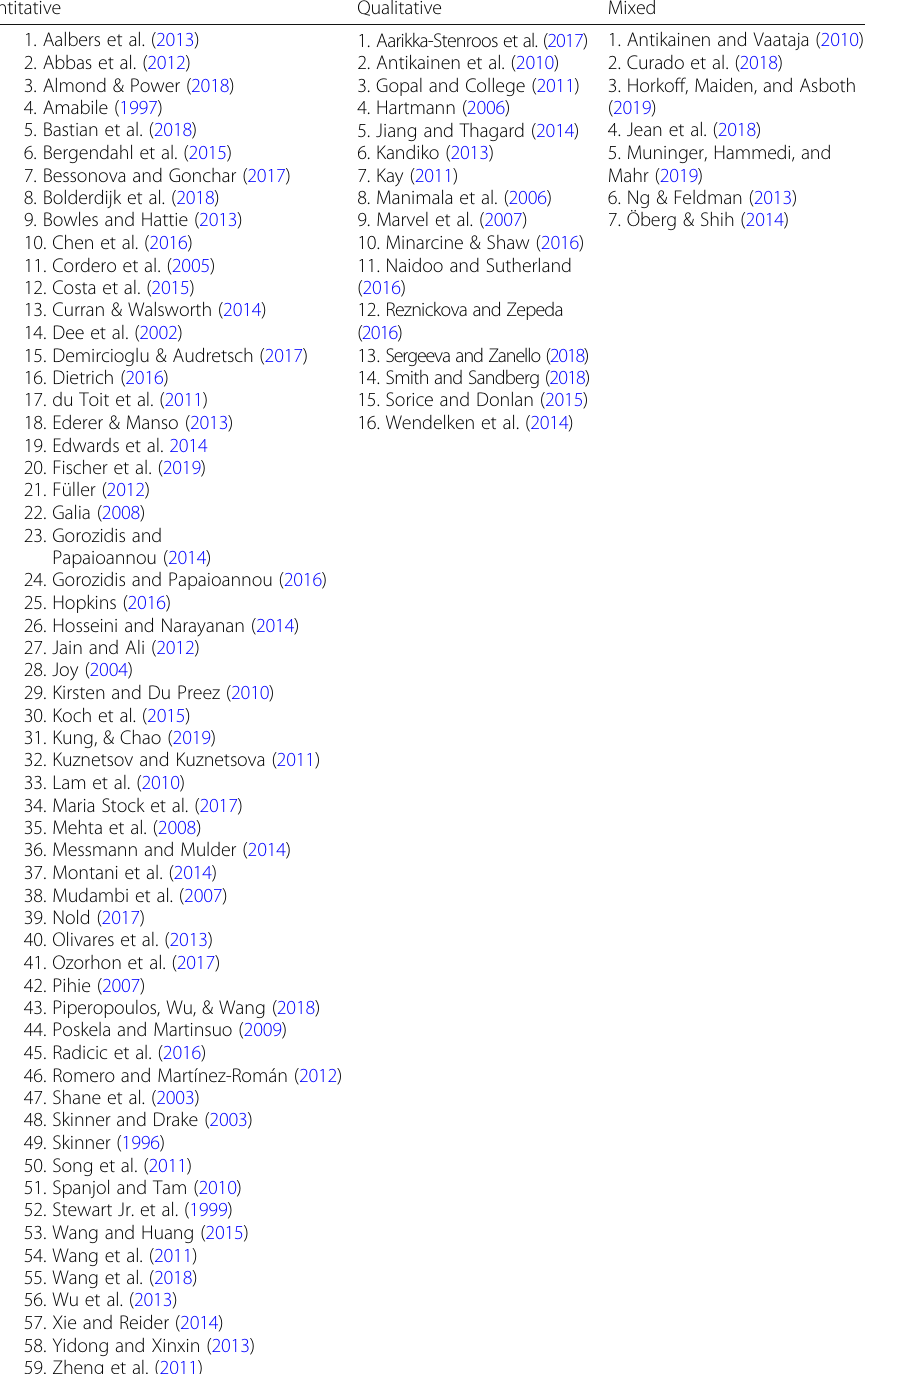
Table 4 Methodology type of included studies Quantitative Qualitative